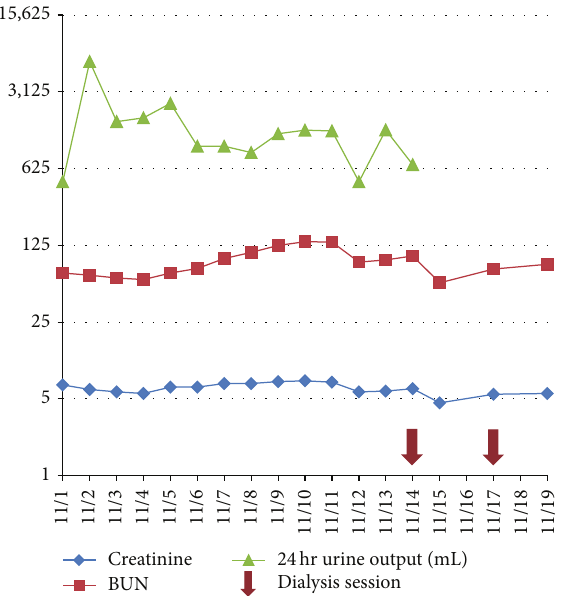
Figure 1: Creatinine and BUN trend during hospitalization. The large arrows reflect the days he had